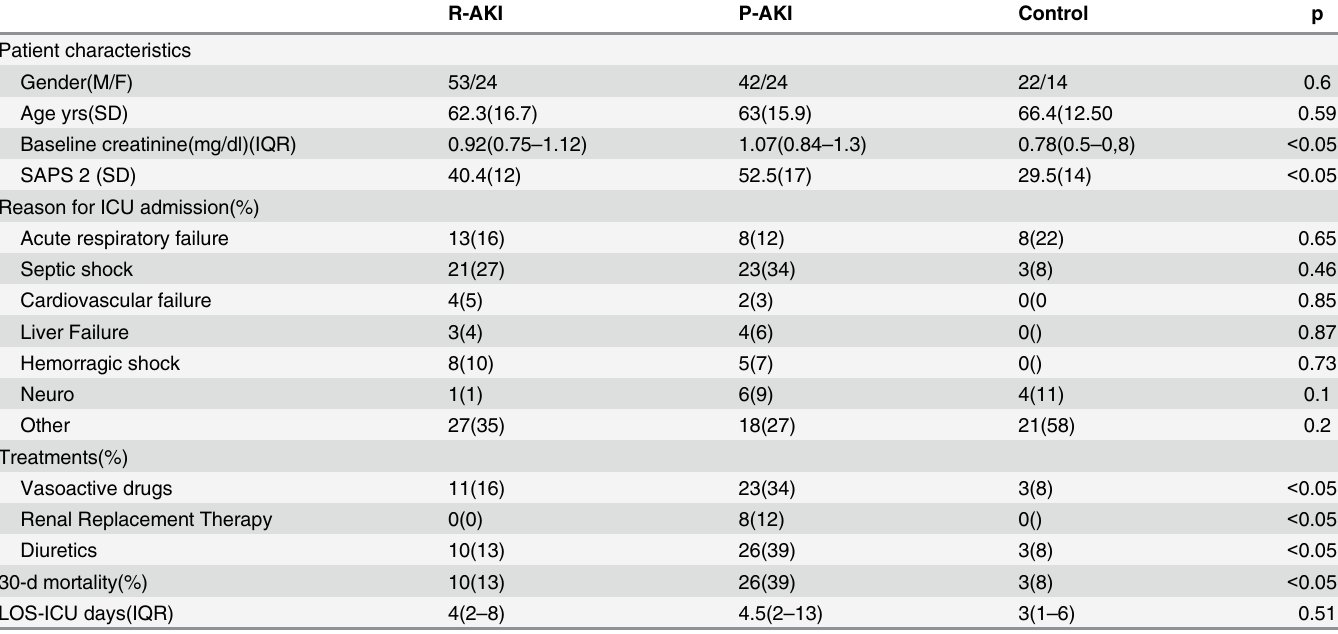
Table 2. Baseline characteristics between patients with Recovered (R-), Persistent (P-) AKI and Control Group. R-AKI P-AKI Control p Patient